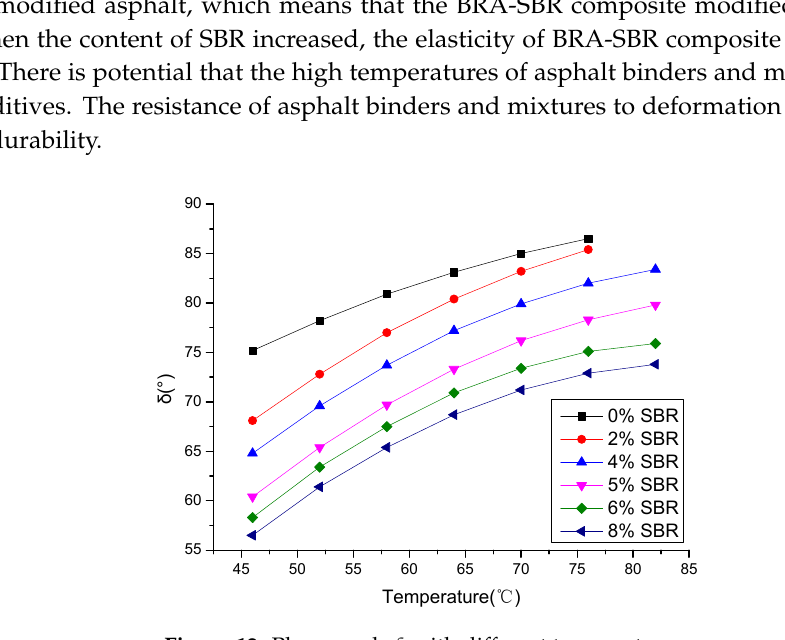
Figure 12. Phase angle δ with different temperatures.